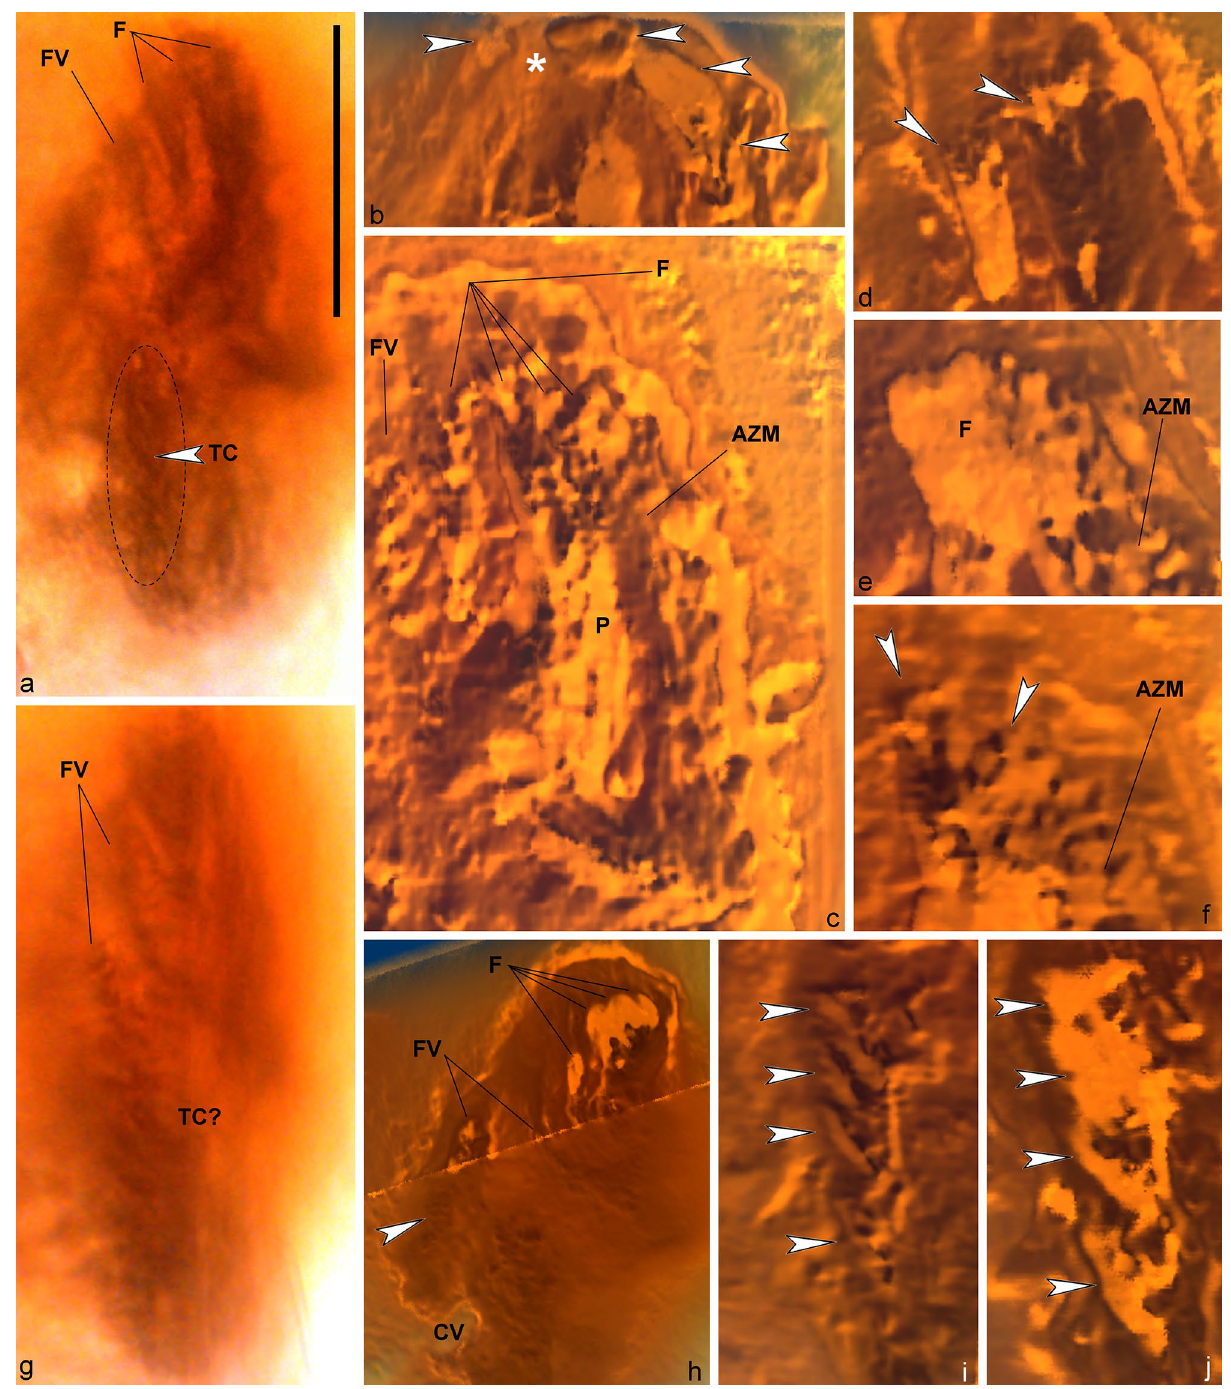
Figure 3. Light microscopy photograph ( a ) and volumetric reconstructions ( b–j ) of Palaeohypothrix bahiensis gen. et sp. nov. holotype. ( a ) Ventral side to show the transverse cirri-like structures (also in i , j ) outlined. Arrowhead points to one of said structures. ( b ) Anterior region of body showing crown membranelles (arrowheads) and one intermembranellar ridge (asterisk). ( c ) Detail of right quadrant of peristome. Figure inset shows some insertion pores of ciliary structures forming the frontal brush immediately ahead of paroral. ( d–f ) Different focal planes of the anterior region to show frontal ciliature. Arrowheads indicate pits from where putative ciliary structures emerged. ( g ) Right lateral view. ( h ) Focal plane of the anterior region to show remnants of the frontal and fronto-ventral ciliature elements. Arrowhead shows insertion places of ciliary structures. ( i , j ) Insertion pits (i) and remnants of transverse cirri-like structures. Legends: AZM adoral zone of membranelles, CV contractile vacuole, F frontal ciliary structures, FV fronto-ventral ciliary structures, P paroral membrane, TC(?) possible transverse cirri-like structures. Scale bar = 20